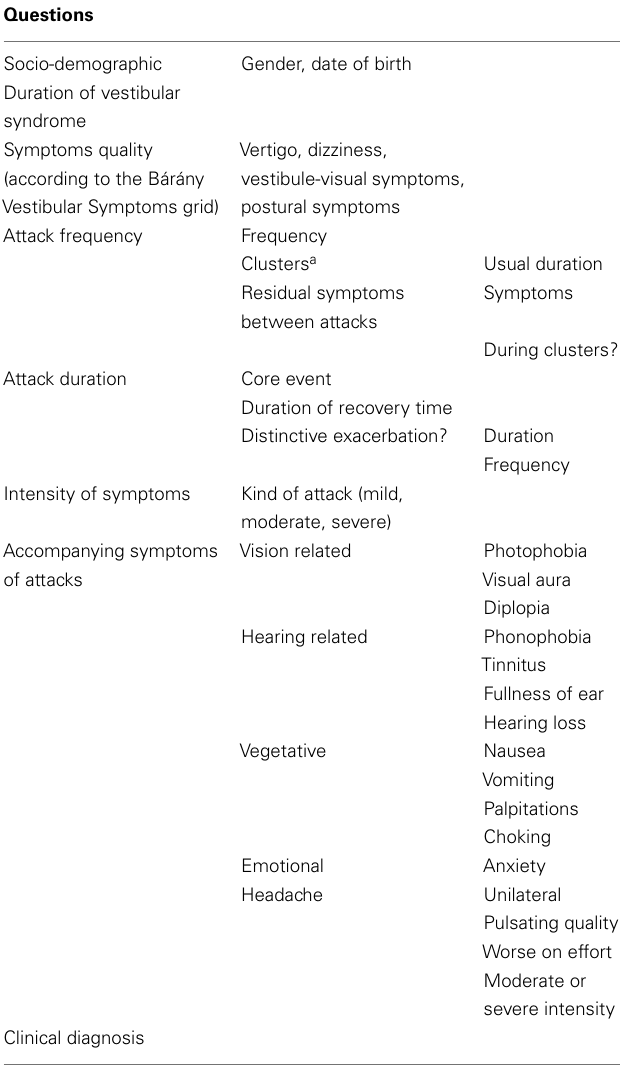
a Clusters refer to the temporal aggregation in episodes of vestibular